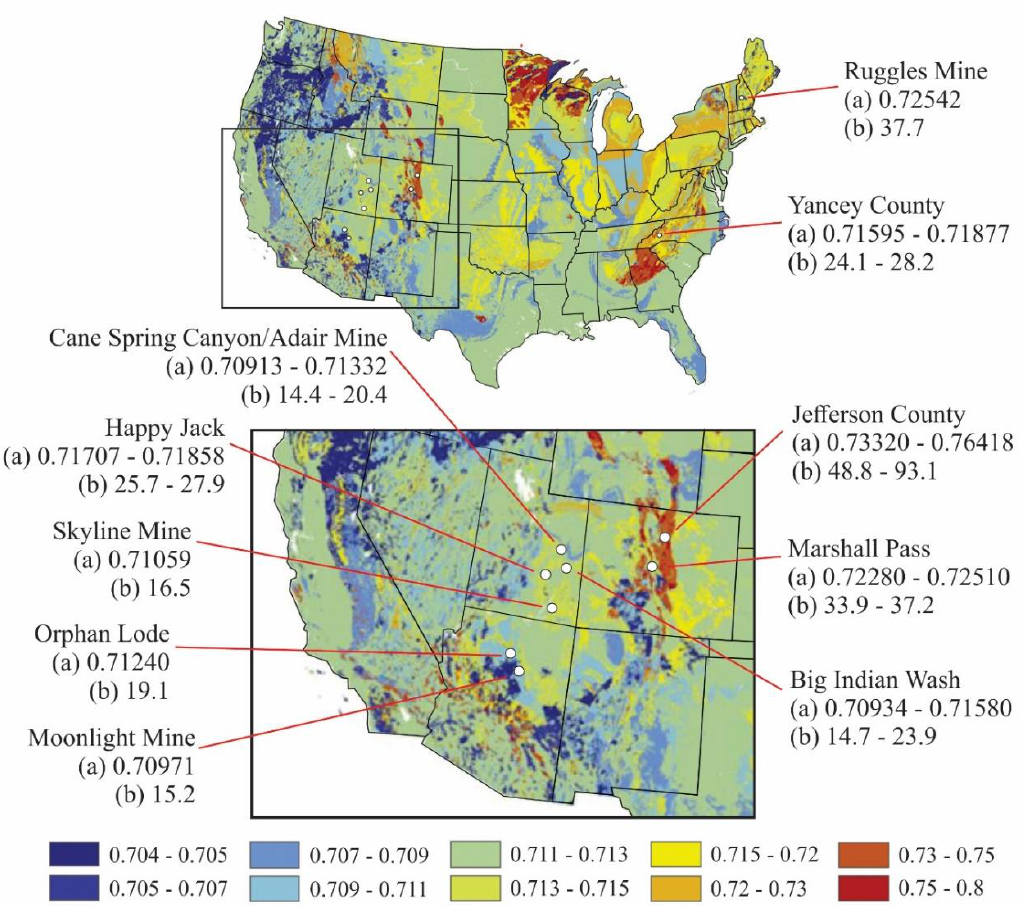
Figure 4. Initial 87 Sr / 86 Sr ( a ) and ε Sr values ( b , as defined in text) of uraninite from this study and Corcoran et al. [59] overlain on 87 Sr / 86 Sr isoscape map for continental U.S. (from Bataille and Bowen [60]).